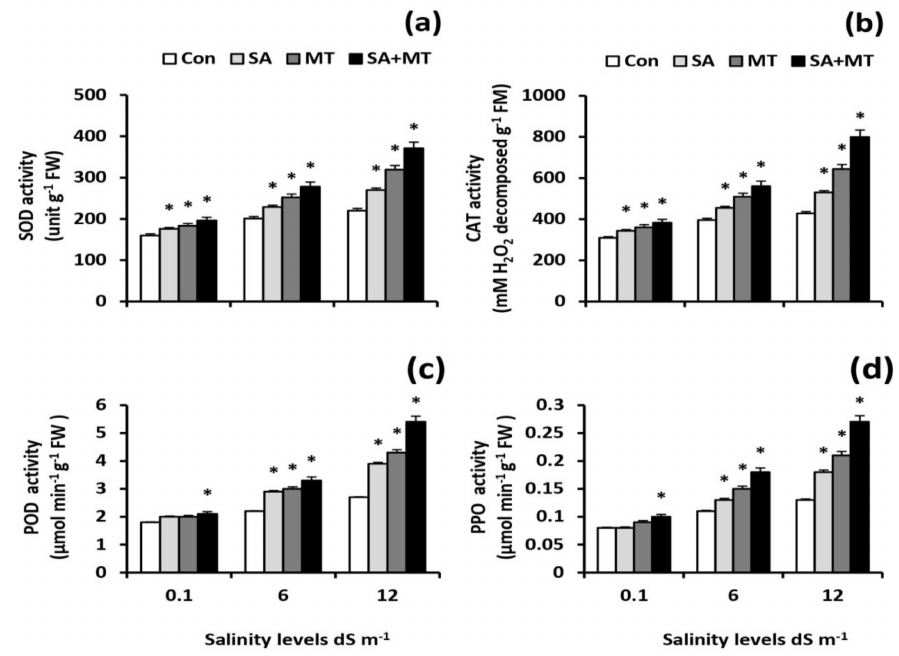
Figure 6. Influence of salicylic acid (SA, 75 mg L − 1 ), melatonin (MT, 70 µ M), and SA (75 mg L − 1 ) + MT (70 µ M) foliar application treatments on the activitylevels of ( a ) superoxide dismutase (SOD), ( b ) catalase (CAT), ( c ) peroxidase (POD), and ( d ) polyphenol oxidase (PPO) in leaves of wheat plants grown under 0.1, 6, and 12 dS m − 1 salinity levels. Data are means of four replicates (n = 4) and bars show standard errors ( ± SE). Asterisk represent significant differences between treatments at the p < 0.05 level according to LSD